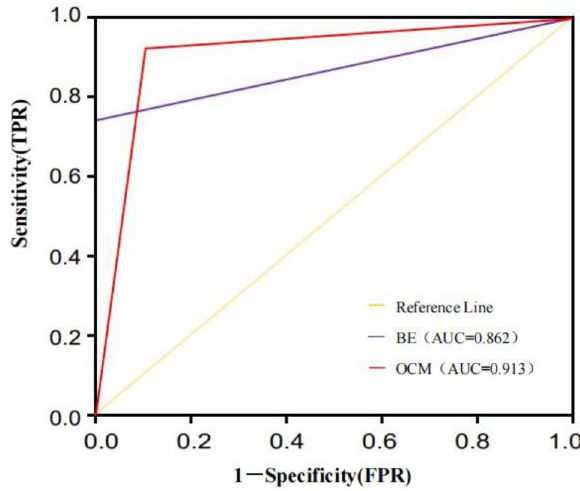
Figure 5. The ROC curves for the BE and